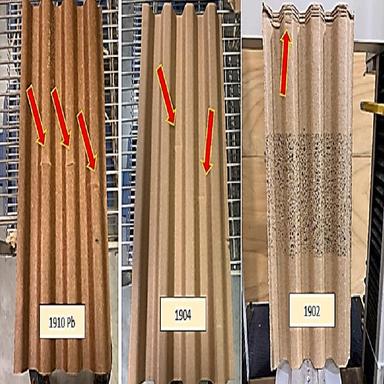
Failure modes of corrugated panels under longitudinal compression.